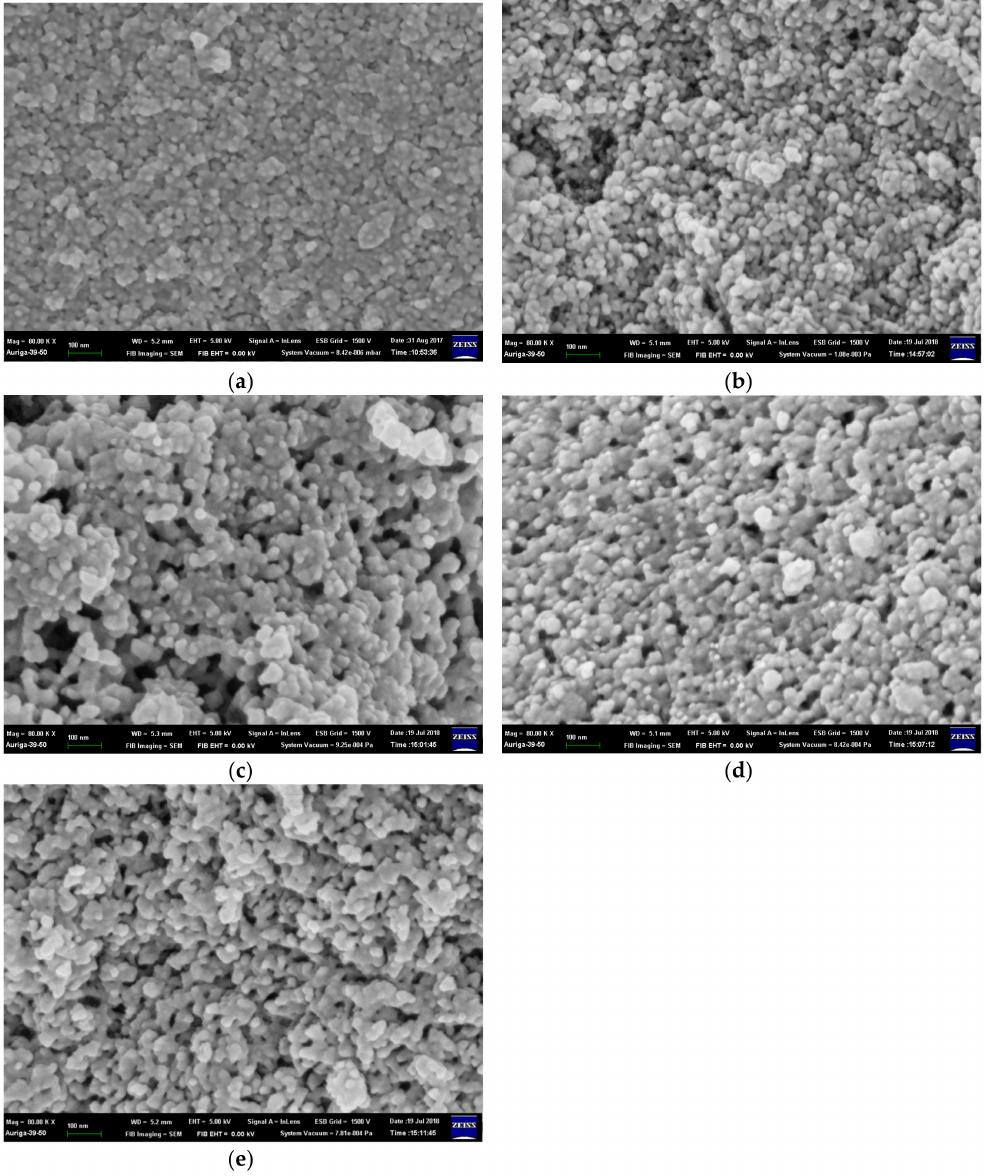
Figure 1. Microstructures of ( a ) bioactive glass (BG), ( b ) BG_B25, ( c ) BG_B50, ( d ) BG _B75, and ( e )